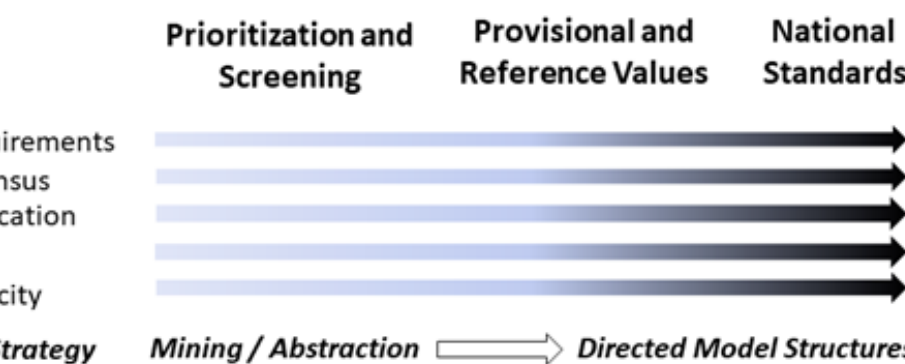
Figure 9. Risk assessment landscape. Adapted from the U.S. EPA Human Health Risk Assessment Strategic Research Action Plan for 2016–2019 [76] for illustration purpose only (Part of NAM-06 presentation, Supplemental File).